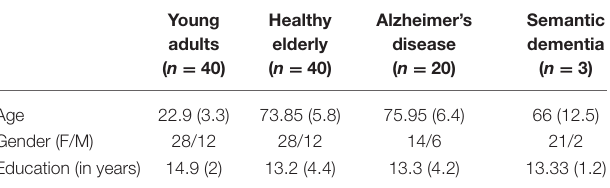
TABLE 1 | Means (and standard deviations) for the demographic data for the young adults (YA), healthy elderly adults (HE), patients with Alzheimer’s disease (AD) and patients with Semantic Dementia